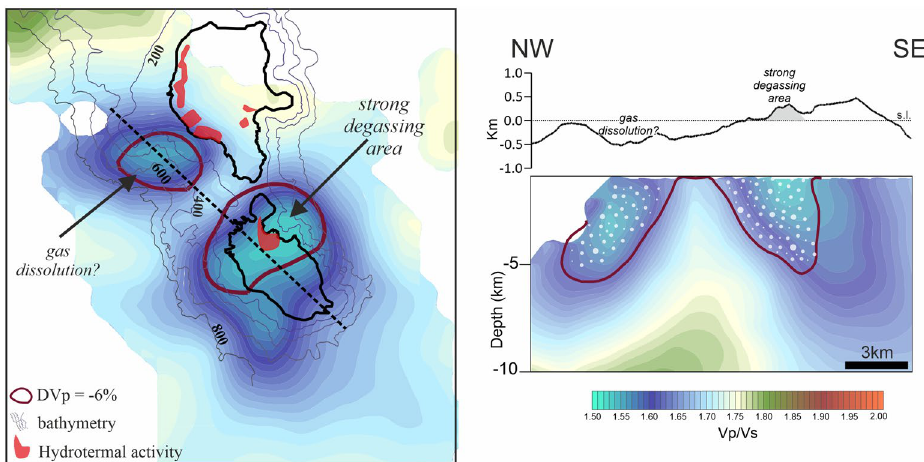
Figure 4. Sketch view of the main results of this study, highlighting the two anomalies of low Vp and low Vp/ Vs we found beneath central-northern Vulcano and the western offshore of Lipari. In map we reported the tomographic results at 2 km depth in terms of Vp/Vs together with the Vp anomalies corresponding to a value of − 6% (purple lines). Isobaths of seafloor depth in correspondence with the main anomalies and sectors of documented hydrothermal activity 24 are also shown (see legend). Along the vertical section cutting the two anomalies (see the profile in map) we analogously reported the Vp/Vs distribution and the contour lines of Vp-variation equal to − 6%. White dots represent the high gas content